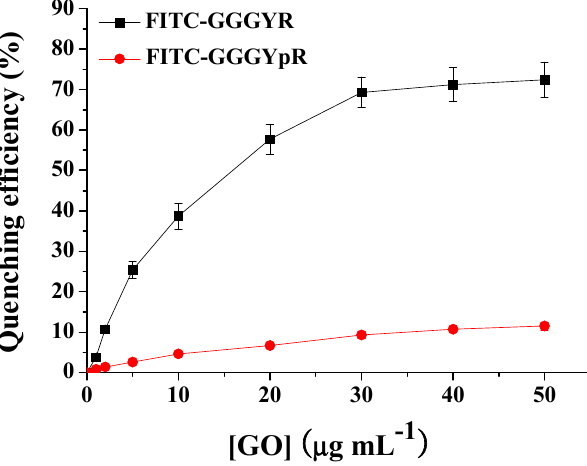
Figure 2. Quenching efficiency of different concentrations of GO toward phosphorylated peptide FITC–GGGYpR and dephosphorylated peptide FITC–Gly–Gly–Gly–Tyr–Arg (GGGYR).